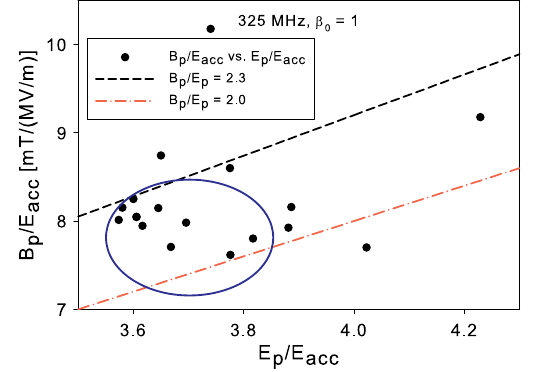
FIG. 18. Peak magnetic field vs peak electric field for various spoke aperture shapes.